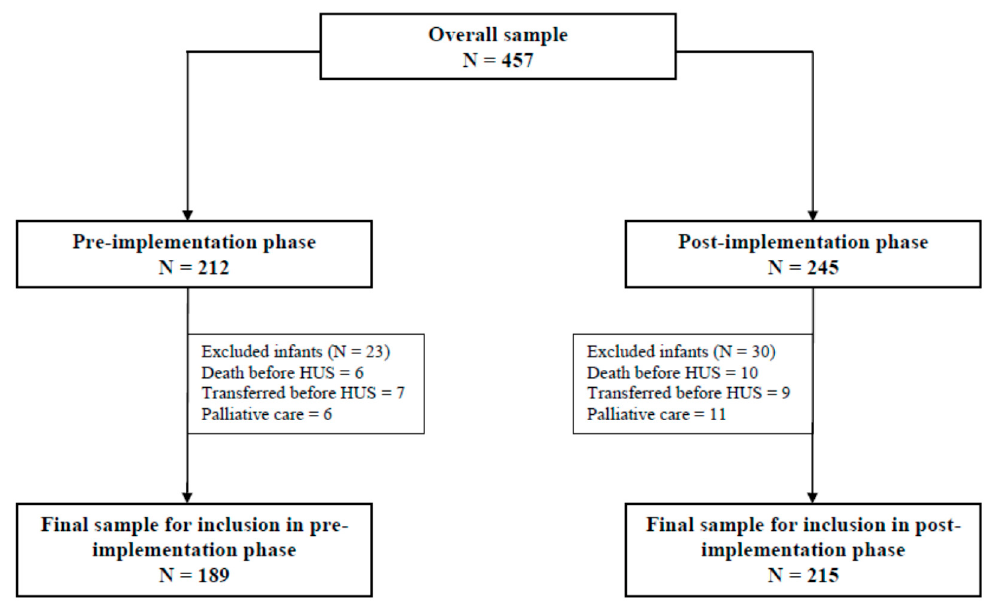
Figure 1. Study Figure 1. Study population.